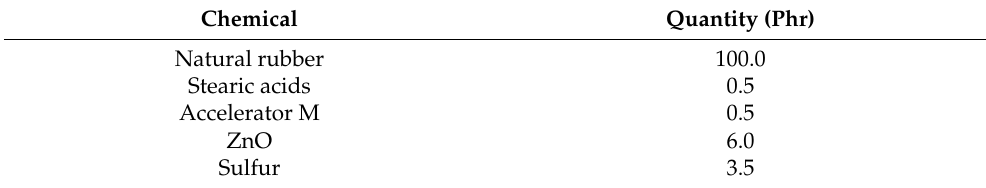
Table 1. Formulation of NR compounds.